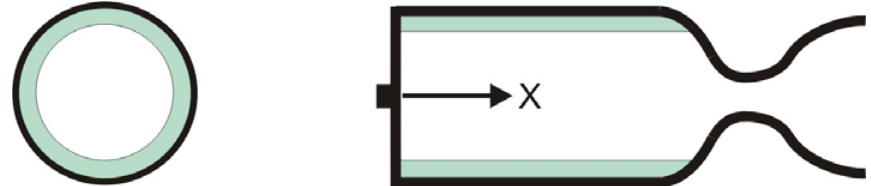
Figure 1. Schematic diagram of cylindrical-grain SRM, showing reference x